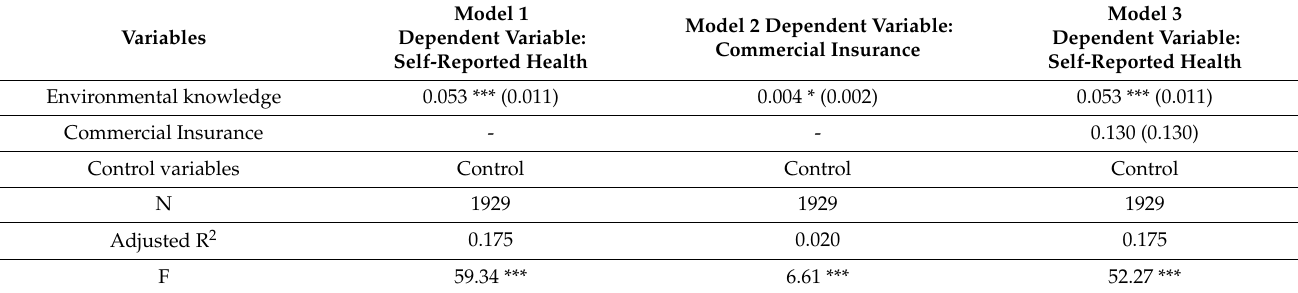
Table A1. Mediation test of commercial insurance on EK and women’s physical health.